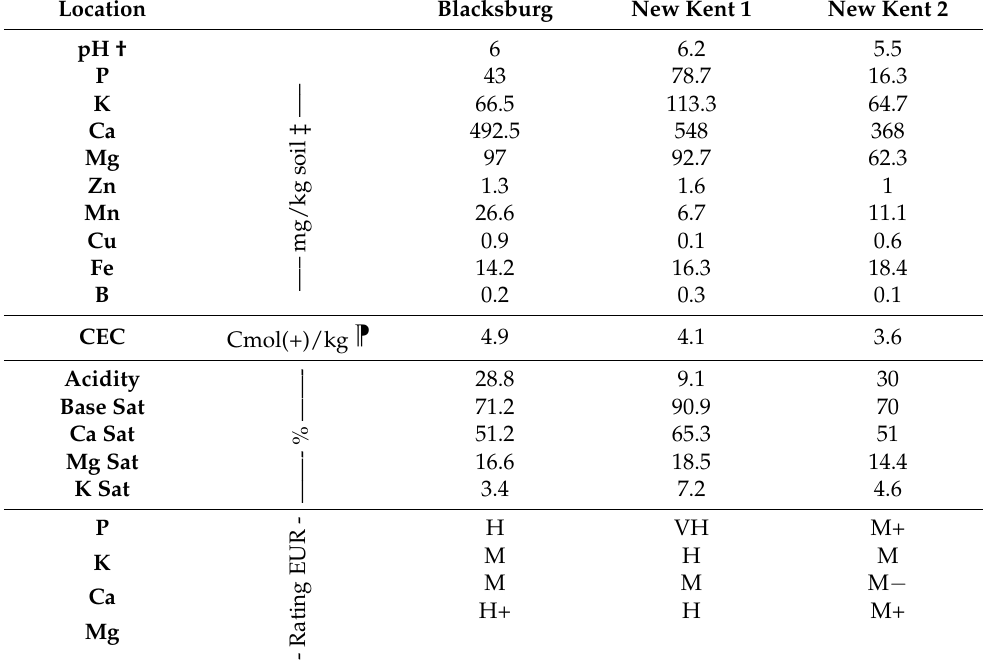
Table 2. Residue sources and application rates for residue management field-based experiments NK1 and NK2 in a corn-wheat/soybean rotation in New Kent, VA.